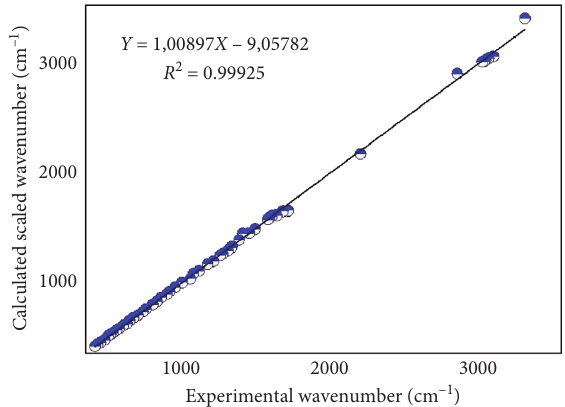
Figure 9: The linear regression between the calculated (scaled) and experimental frequencies of